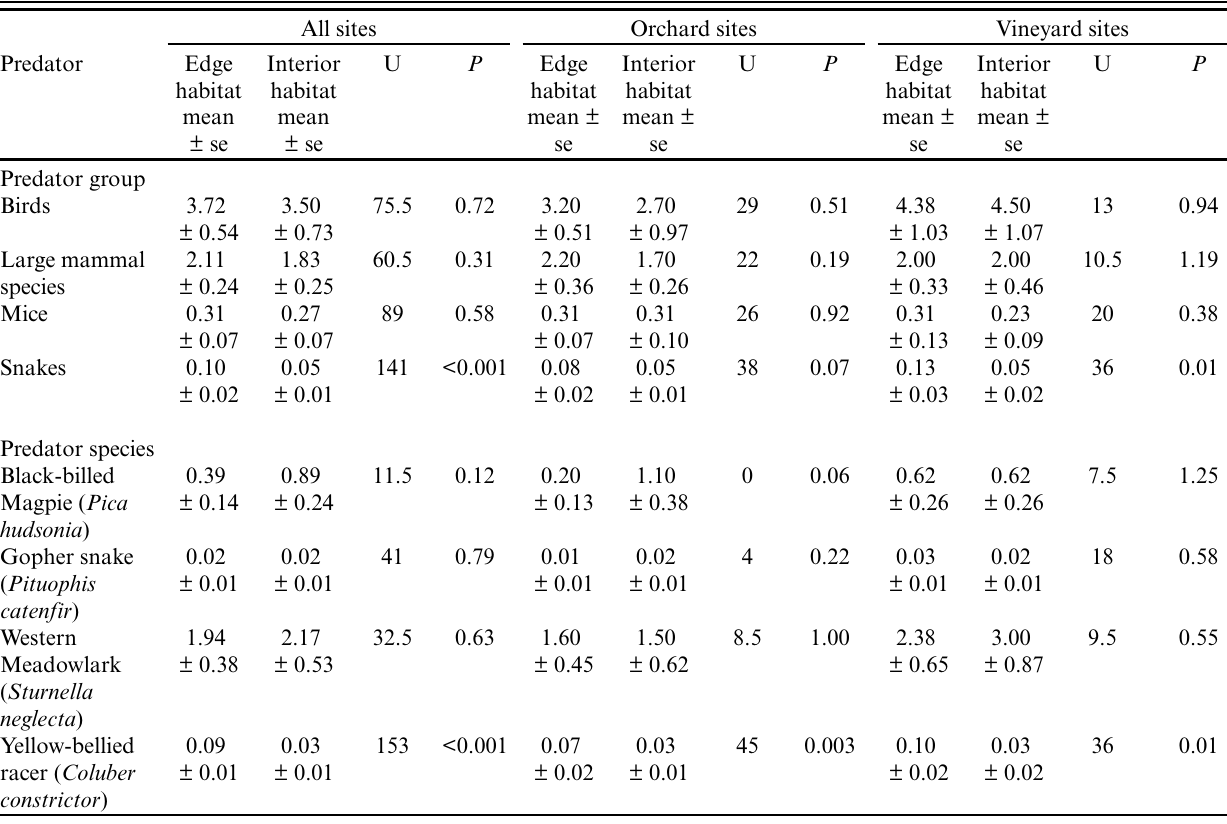
Table 7 . The relative abundance of potential predators of songbird nests in edge and interior sagebrush habitat. Predators were analyzed by major taxonomical group and as individual species. Edge habitat was located adjacent to vineyard (n = 8) or orchard (n = 10). All sites includes orchard and vineyard sites pooled. Differences between edge and interior sites were tested with paired Wilcoxon rank sign